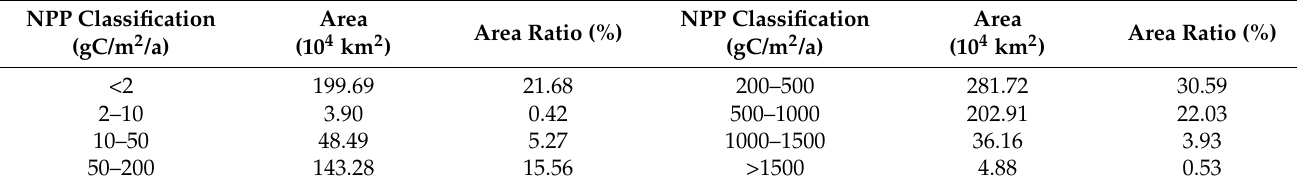
Figure 6. The spatial distribution of vegetation NPP in China from 2000 to 2019 (IMP: Inner Mongolia Plateau, NEP: Northeast Plain, QTP: Qinghai-Tibet Plateau, LP: Loess Plateau, NCP: North China Plain, SCB: Sichuan Basin). Table 5. National vegetation NPP classification statistics from 2000 to